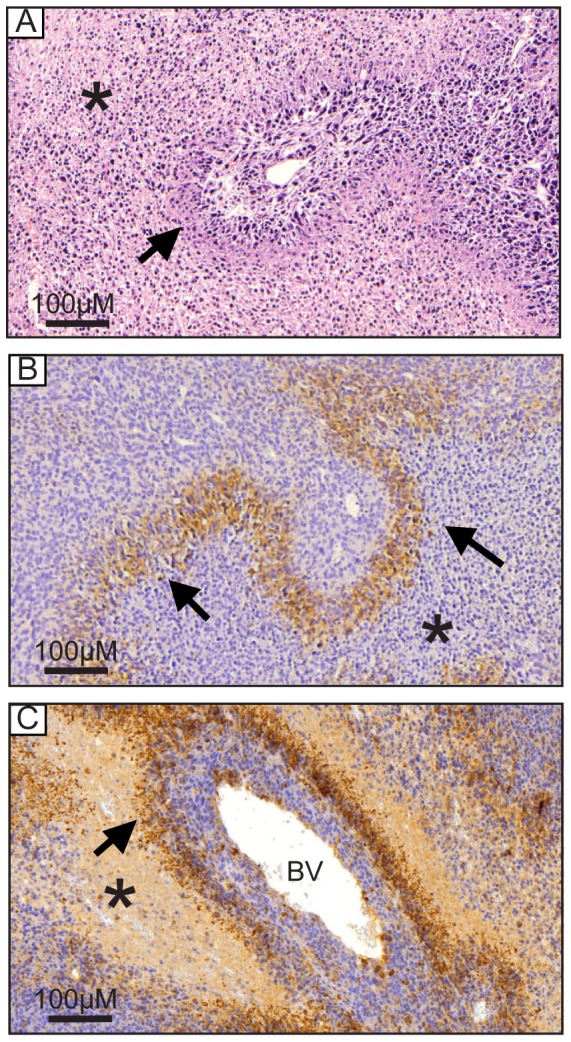

In vivo analysis shows hypoxia and gal-3 accumulation in pseudopalisades.NG97ht cells were transplanted subcutaneously in nude mice and tumors formed were excised and analyzed microscopically. A. Tumors present necrotic foci (* all figures) and pseudopalisades (arrows). HE staining. B. Tumors demonstrated hypoxic regions (pimonidazole adducts) in pseudopalisades (brown areas, arrows). C. Immunohistochemistry for gal-3 demonstrated pseudopalisades intensely stained (brown areas, arrows). Sparse cells in non-necrotic areas around blood vessels (BV) were also positive. Scale bar 100 µm.